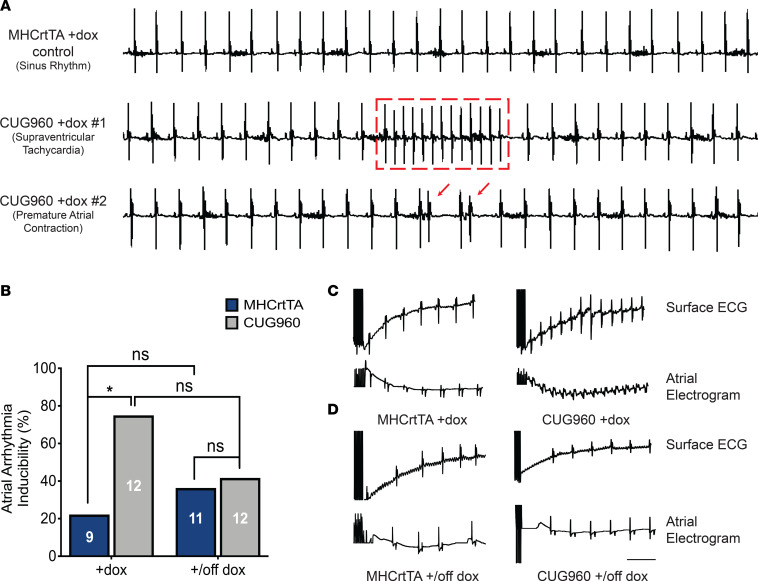
CUG960 mice exhibit an increased and reversible predisposition to atrial arrhythmias.(A) Baseline arrhythmias observed in surface ECG recordings for CUG960 +dox mice in comparison with MHCrtTA +dox controls. (B) Incidence of atrial arrhythmias induced by electrical pacing in CUG960 vs. MHCrtTA control mice in response to dox induction initiated at PN1 for 2 months and dox withdrawal for 1 month after 2 months of induction initiated at PN1. (C) Representative recordings of surface and intracardiac atrial electrograms in CUG960 +dox and MHCrtTA +dox control mice after rapid atrial pacing. (D) Representative recordings of surface and intracardiac atrial electrograms in CUG960 +/off dox and MHCrtTA +/off dox control mice after rapid atrial pacing. Numbers of animals analyzed are indicated in corresponding bars. Data were analyzed using Fisher’s exact test. *P < 0.05. Scale bar: 200 milliseconds. PN1, postnatal day 1; dox, doxycycline.